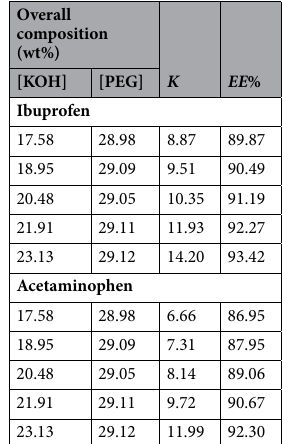
Table 3. Values of partitioning coefficients, K , and extraction efficiency, EE %, of drugs for the system {PEG 600 + KOH + H 2 O} at 298.15 K and atmospheric pressure (≈ 85 kPa). The standard uncertainties σ for temperature, pressure and partitioning coefficient are: σ ( T ) = 0.05 K, σ ( p ) = 0.5 kPa and σ ( K ) = 0.15,